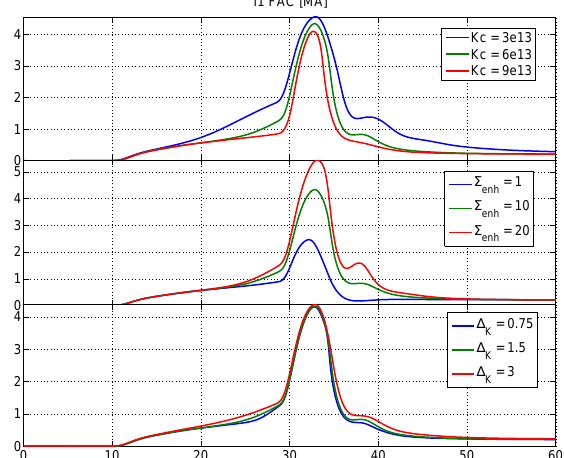
Fig. 2. The response of the WINDMI model when the values of K 0 k , 6 enh and 1 K are varied refers to the nominal plot shown by the blue curve in Fig. 1. The threshold parallel kinetic energy above which the conductivity becomes strongly enhanced is varied 3 − 9 × 10 13 J, the saturation level of the conductivity is varied in the range of 1 − 20S, and the rate of increase in the conductivity is varied in the range of 0 . 75 − 3 × 10 13 J.